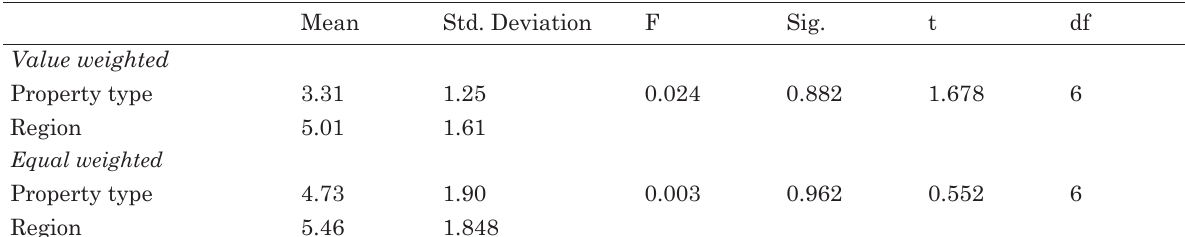
Table 12. Test for equality of means between coefficient types